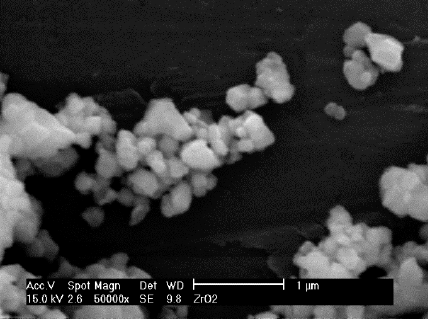
Figure 1. As received ZrO 2 nanoparticles.